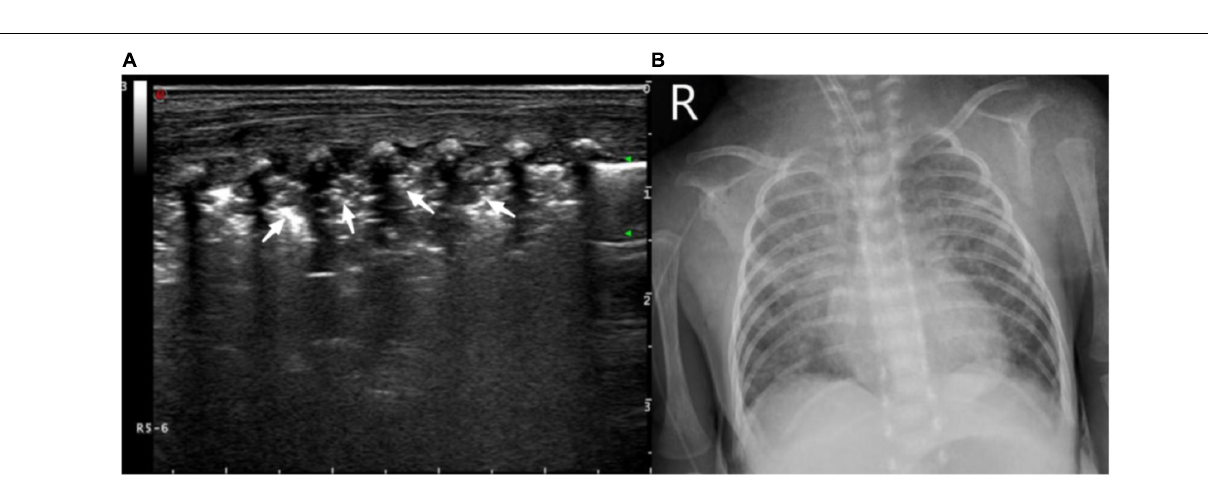
FIGURE 5 | (A) Ultrasound manifestations of large-area consolidation of newborn lungs. Pulmonary ultrasound shows a large irregular consolidation area with air bronchogram (white arrow) and the disappearance of the pleural line and A-line. The disappearance of the pulmonary slip and lung pulse can be observed with real-time ultrasound. (B) X-ray showing a diffuse patchy fuzzy shadow of both lungs and a bronchogram of lower